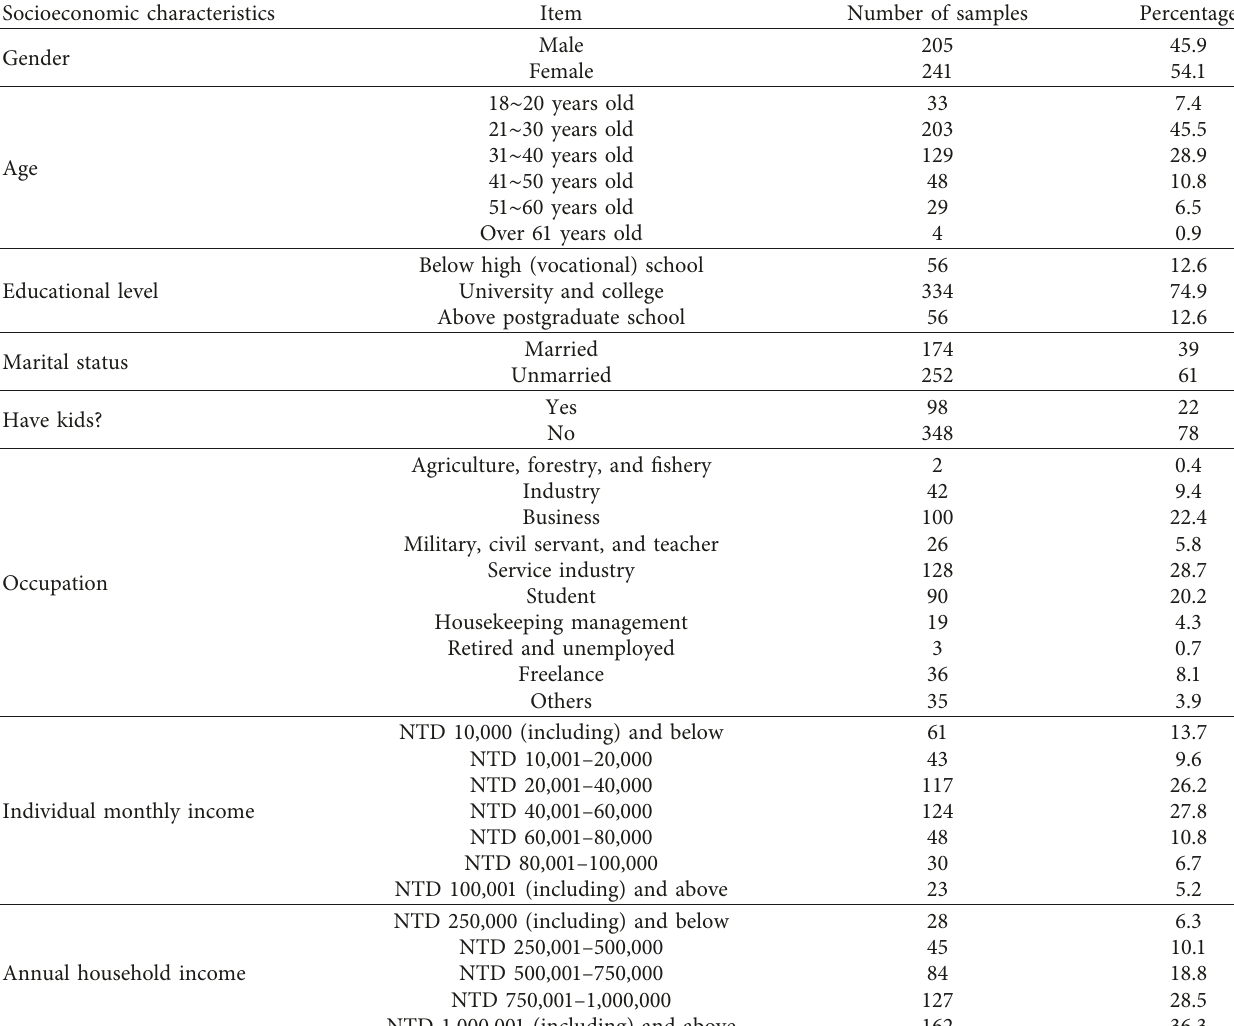
Table 2: Socioeconomic characteristics